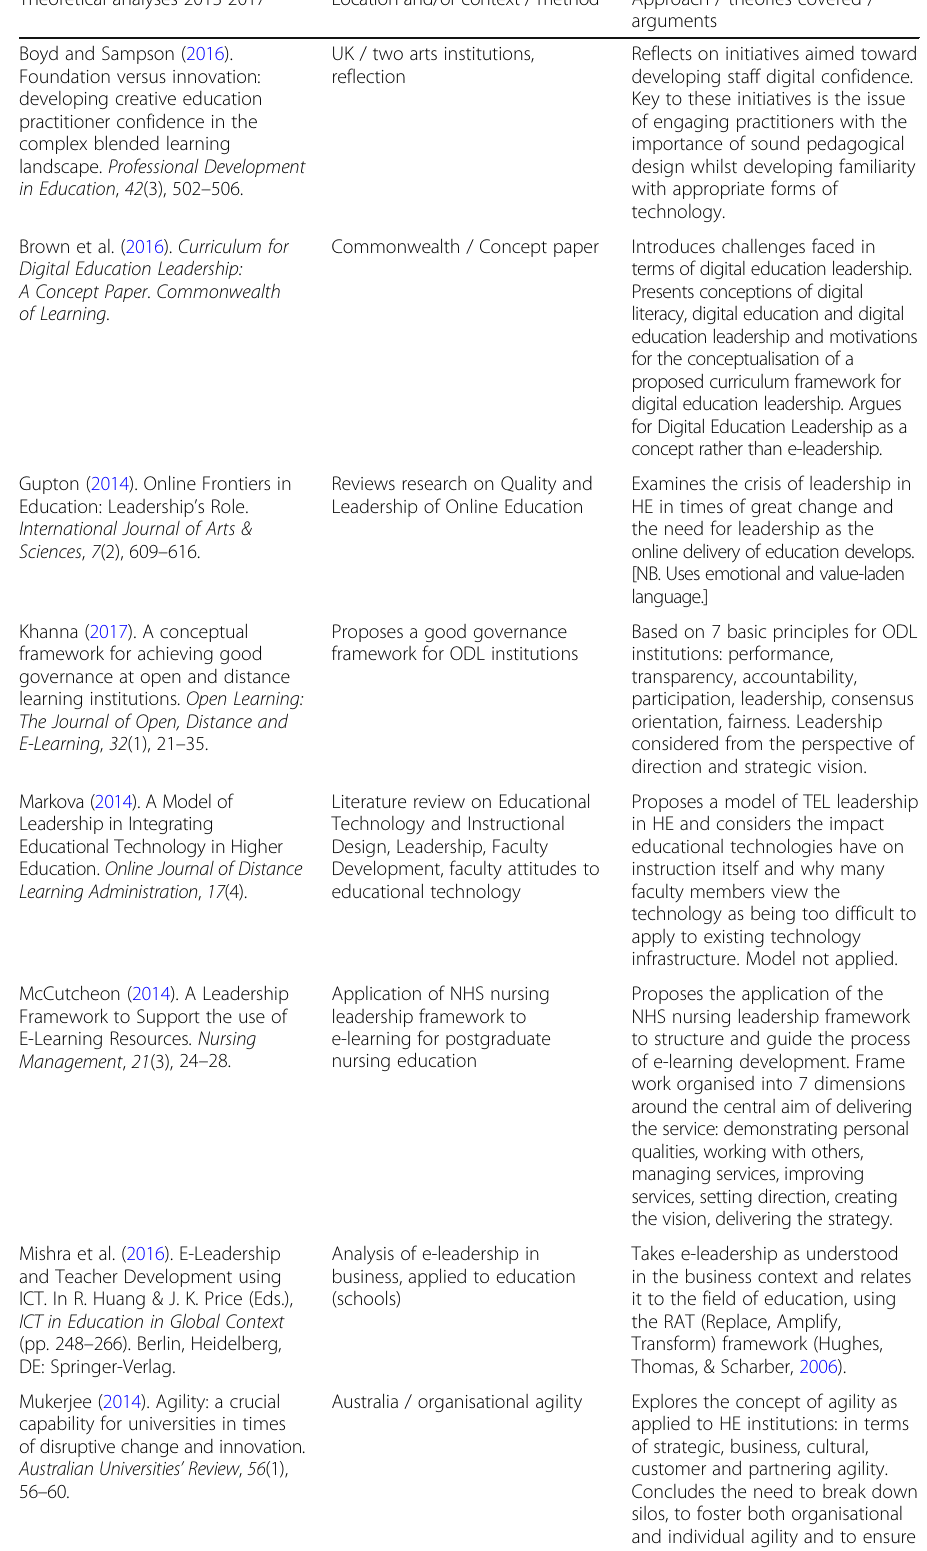
Table 3 Results: Theoretical analyses Theoretical analyses 2013-2017 Location and/or context / method Approach / theories covered /